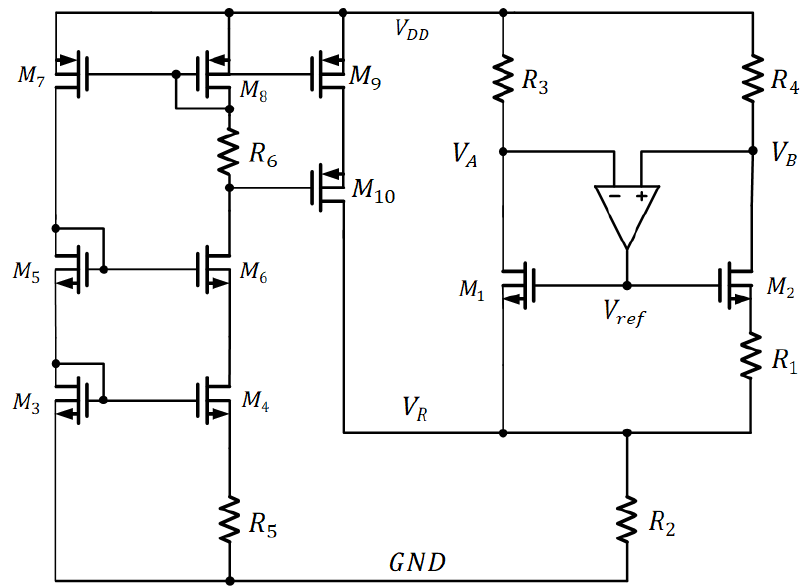
Figure 3. The Sub-1V MOS Threshold Voltage Circuit.